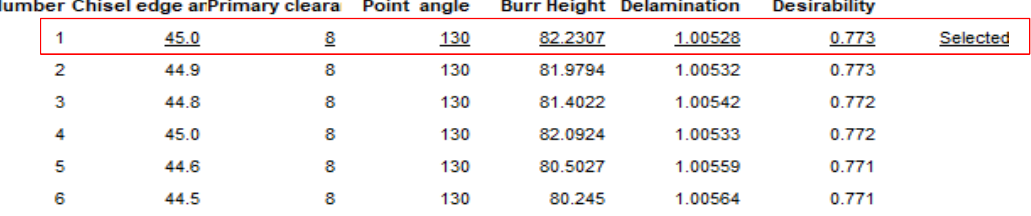
Table 7. Prediction of the optimized model of twist drill bit for edge defect analysis when drilling CFRP/Al7075-T6 stack-up